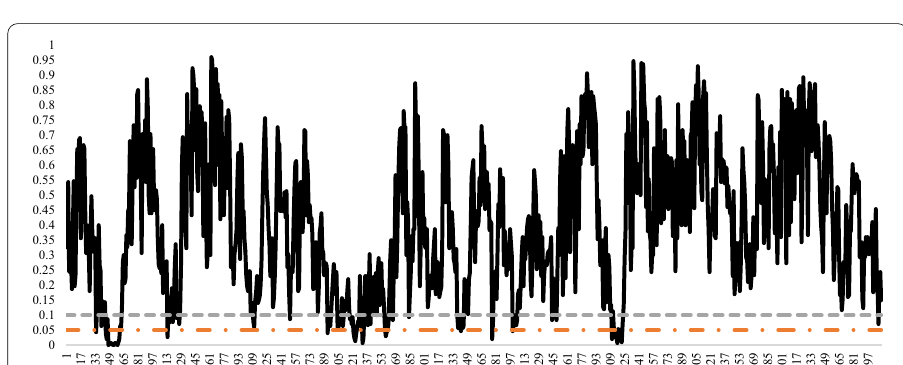
Fig. 30 The evolving p values of the GS test statistic checked for the Gold in 100-day window length